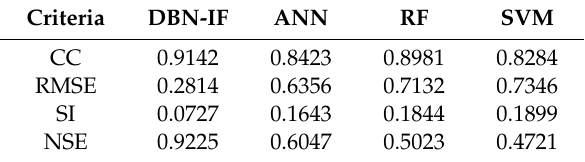
Table 11. The CC, RMSE, SI, NSE of WVHT predictions with lead time = 12